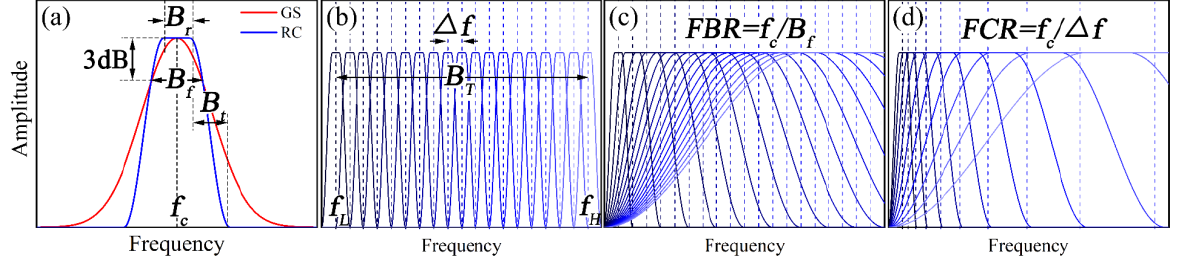
Figure 4. ( a ) Comparison of GS and RC filters, frequency distributions of ( b ) RC, ( c ) FBR-RC, and ( d ) FSR-FBR-RC filter bands. ( d ) FSR-FBR-RC filter